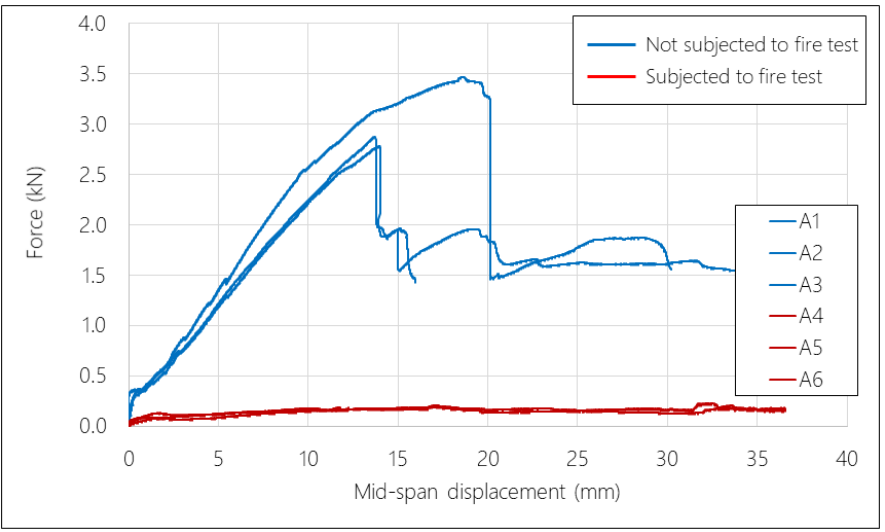
Figure 10. Force versus displacement curves for specimens in Series A.